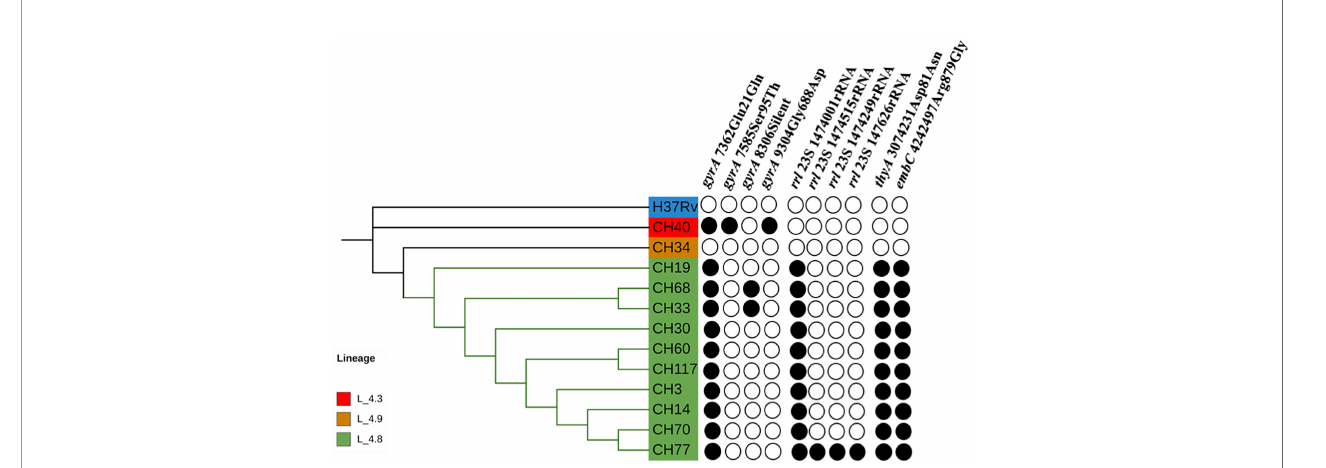
FIGURE 1 | Phylogenetic tree showing the relationships among isolates belonging to SIT53. Mutation patterns observed in gyrA , rRNA operon ( rrl ), thyA (para- aminosalicylic acid, PAS), and embC (ethambutol) are shown as fi lled